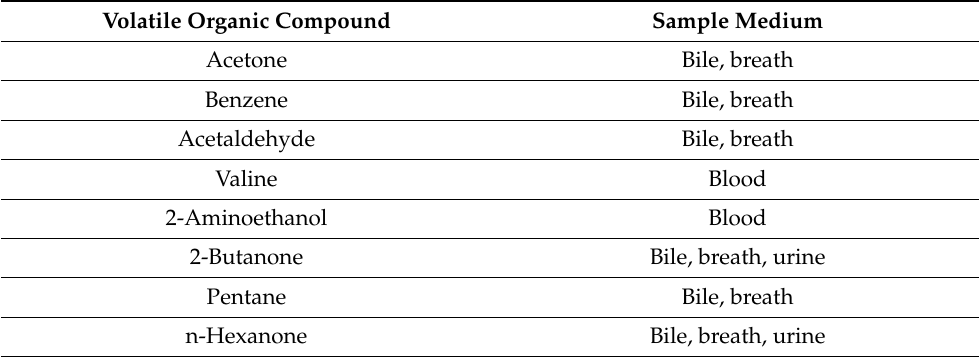
Table 2. A list of frequently identified eight volatile organic compounds in patients with hepatobiliary and pancreatic cancer. Volatile Organic Compound